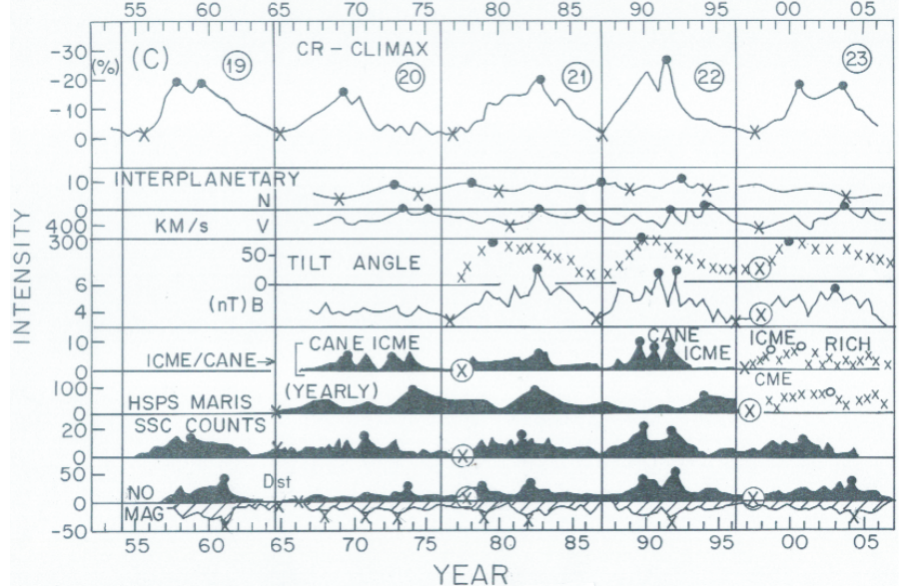
Fig. 1c. Top plot: CR (Cl´ımax neutron monitor, repeated). Further plots are for interplanetary parameters, namely, number density N , solar wind speed V and total magnetic field B , Tilt angles (crosses), CMEs and ICMEs, HSPS (high-speed plasma streams), and terrestrial parameters, namely, occurrence frequency of Storm Sudden Commencement events, occurrence frequency of the geomagnetic disturbance index D st events of negative magnitudes exceeding 50nT, and the average 3-monthly magnitudes of D st